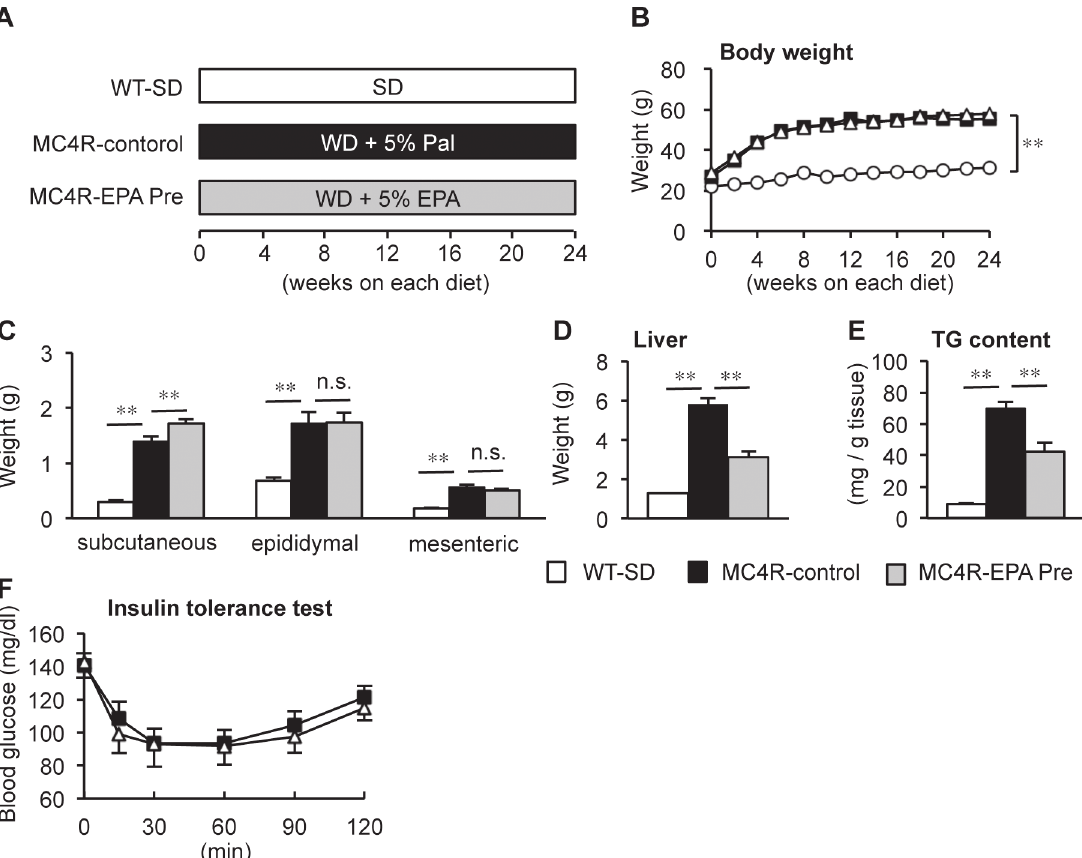
Fig 1. Body weight and tissue weights in MC4R-KO mice treated with EPA for 24 weeks. (A) Experimental protocol of preventive EPA treatment. Growth curve (B) and weights of the subcutaneous, epididymal and mesenteric white adipose tissues (C) and liver (D) of male MC4R-KO (MC4R) and wildtype (WT) mice. WT-SD, WT mice fed standard diet (SD); MC4R-control, MC4R-KO mice fed Western diet (WD) supplemented with 5% (wt/wt) palmitate; MC4R-EPA Pre, MC4R-KO mice fed WD supplemented with 5% (wt/wt) EPA for 24 weeks. Open circle, WT-SD; Open triangle, MC4R-control; closed square, MC4R-EPA Pre. (E) Liver triglyceride (TG) content at 24 weeks. (F) Insulin tolerance test (ITT) at 12-week WD feeding. Open triangle, MC4R-control; closed square, MC4R-EPA Pre. ** P < 0.01; n.s., not significant. WT-SD, n = 8; MC4R-control, n = 7; MC4R-EPA Pre, n = 10.